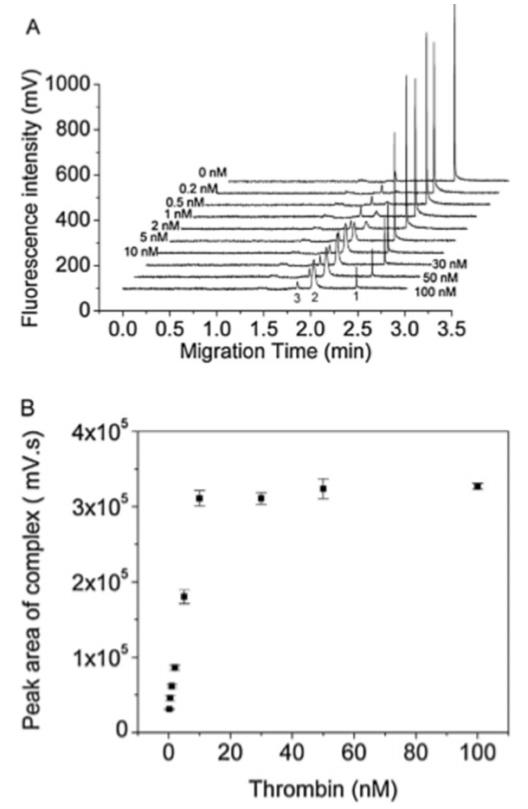
Figure 2. Capillary electrophoresis using laser-induced fluorescence detection (CE-LIF) detection of thrombin using tetramethylrhodamine TMR labeled Toggle-25. ( A ) Electropherograms